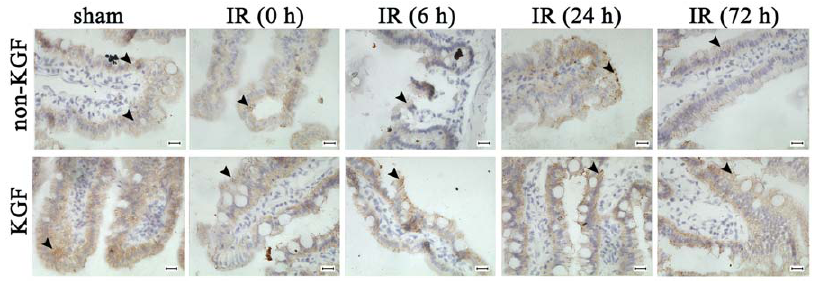
Figure 6. Changes in Claudin-1 expression in acute intestinal I/R mice after KGF treatment by immunohistochemistry. Claudin-1 expression was detected at 0 h, 6 h, 24 h and 72 h after I/R with or without KGF treatment, compared with the sham group. The reticular structures were significantly improved and maintained after KGF treatment at all stages of I/R injury when compared with the sham group. Arrow, Claudin-1 expression. Original magnification: 6 630, n=6 per group. Scale bar=25 m m.